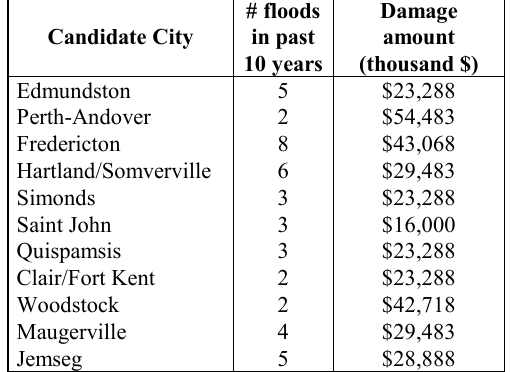
Table 1 Candidate communities along Saint John River,